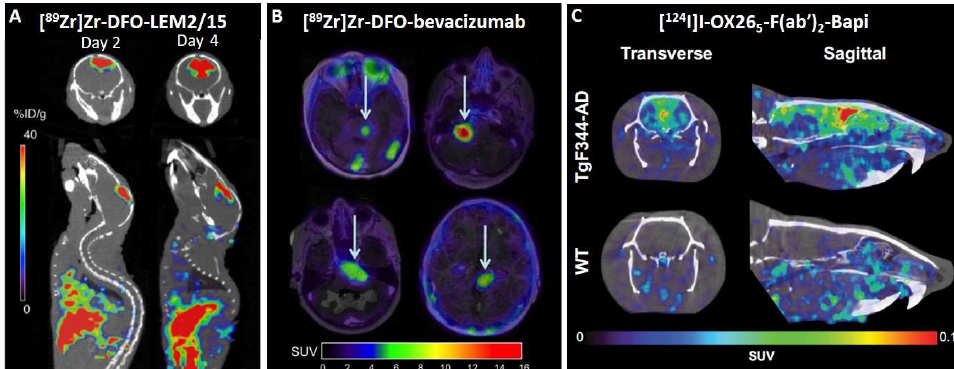
Figure 2. Examples of immunoPET images in preclinical and clinical neuroscience. ( A ) Representative fused PET/CT images of coronal and sagittal planes at 2 and 4 days post-injection containing TS543 brain tumors with [ 89 Zr]Zr-DFO-LEM2/15. (Image: Adapted from Ref. [81]). ( B ) PET/MR fusion images of four different pediatric patients with DIPG where four tumors showed variable uptake of [ 89 Zr]Zr-DFO-bevacizumab (arrows). (Image: Adapted from Ref. [84]). ( C ) Representative in vivo PET images from TgF344-AD and WT rats 3 days post-administration of [124I]I-OX26 5 -F(ab ´ ) 2 -Bapi. (Image: Adapted from Ref. [32]).